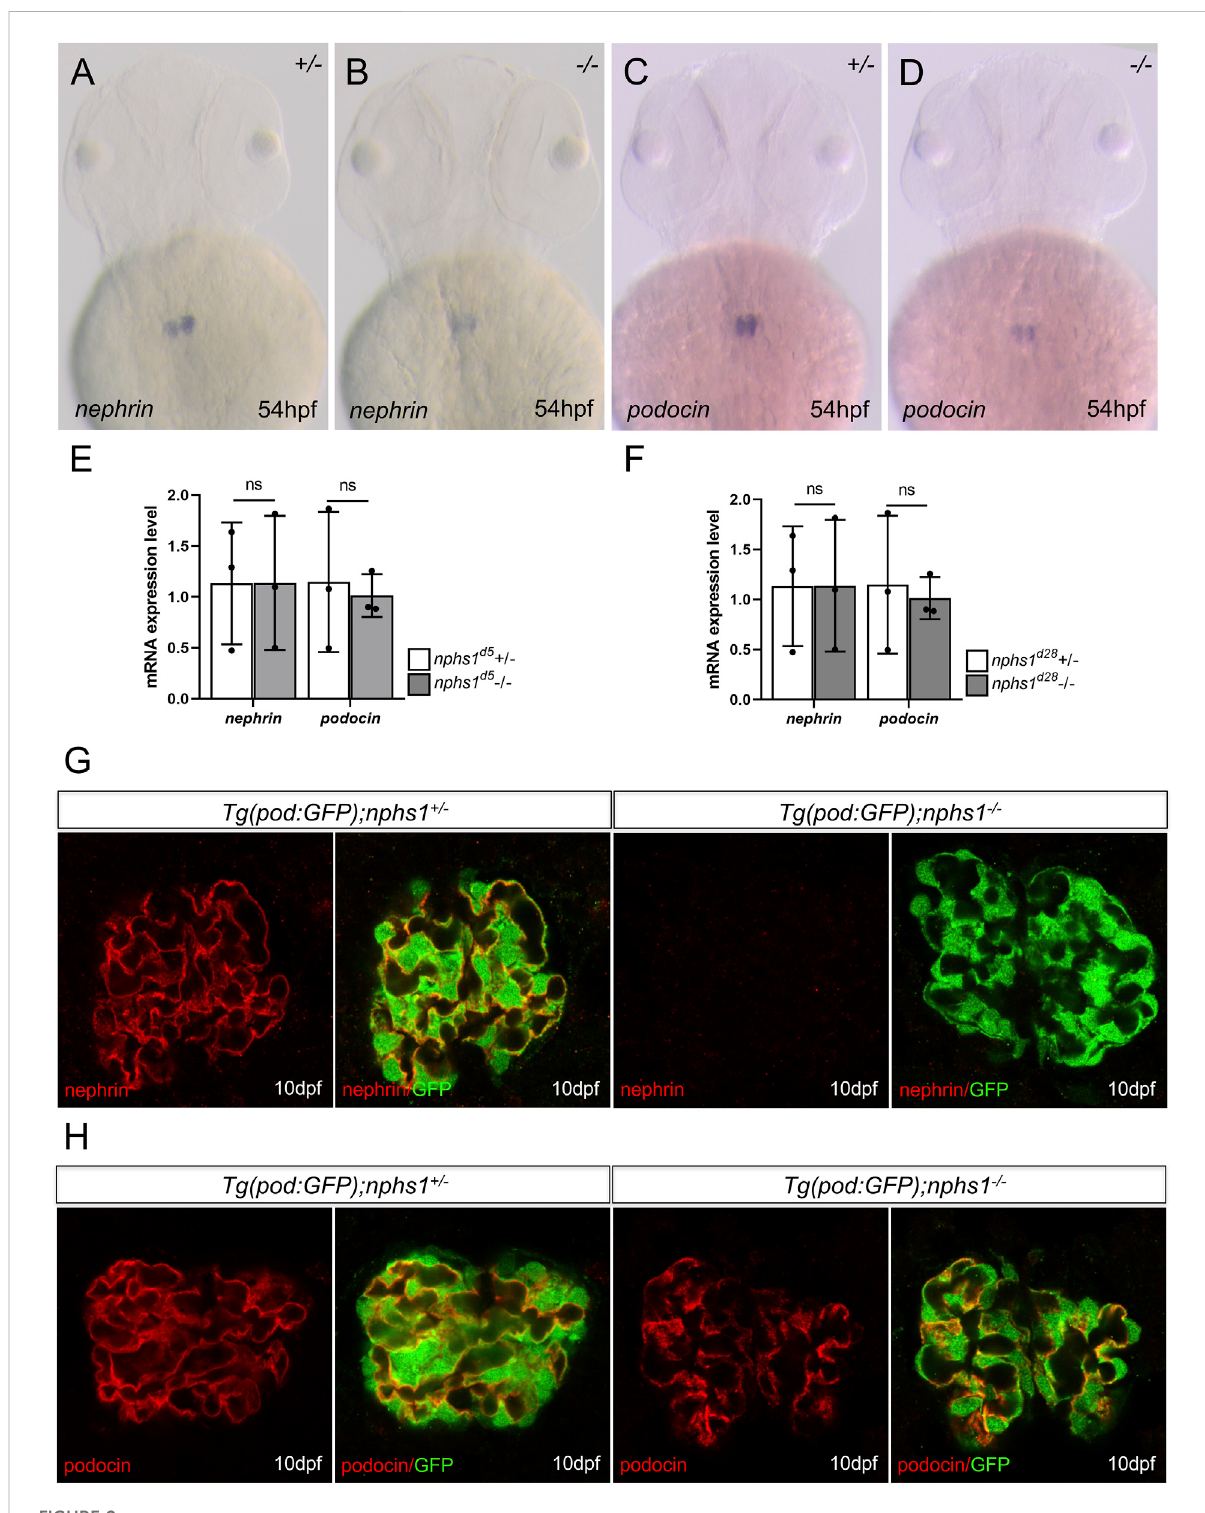
The expression analyses of nephrin and podocin in nphs1 mutants. Whole-mount in situ hybridization for nephrin (A – B) and podocin (C – D) at 54 hpf (E – F) Quantitative PCR analyses ofmRNA levels of nphs1 and nphs2 show no statistically signi fi cant difference betweennphs1 heterozygotes (+/-) and nphs1 homozygous mutants (-/-) at 7 dpf for both 5bp deletion (d5) and 28bp deletion (d28) mutant alleles. The expression level is normalized to that of e fl α . The error bars show the standard error of the mean (SEM). (G – H) Confocal images of Immuno fl uorescence staining for nephrin (G, red) and podocin (H, red) at 10 dpf. Podocytes are marked by GFP expression (green) by the Tg (pod:GFP) transgene. No nephrin expression is detected in Tg (pod:GFP); nphs1-/- at 10 dpf, while podocin is present with a grainy